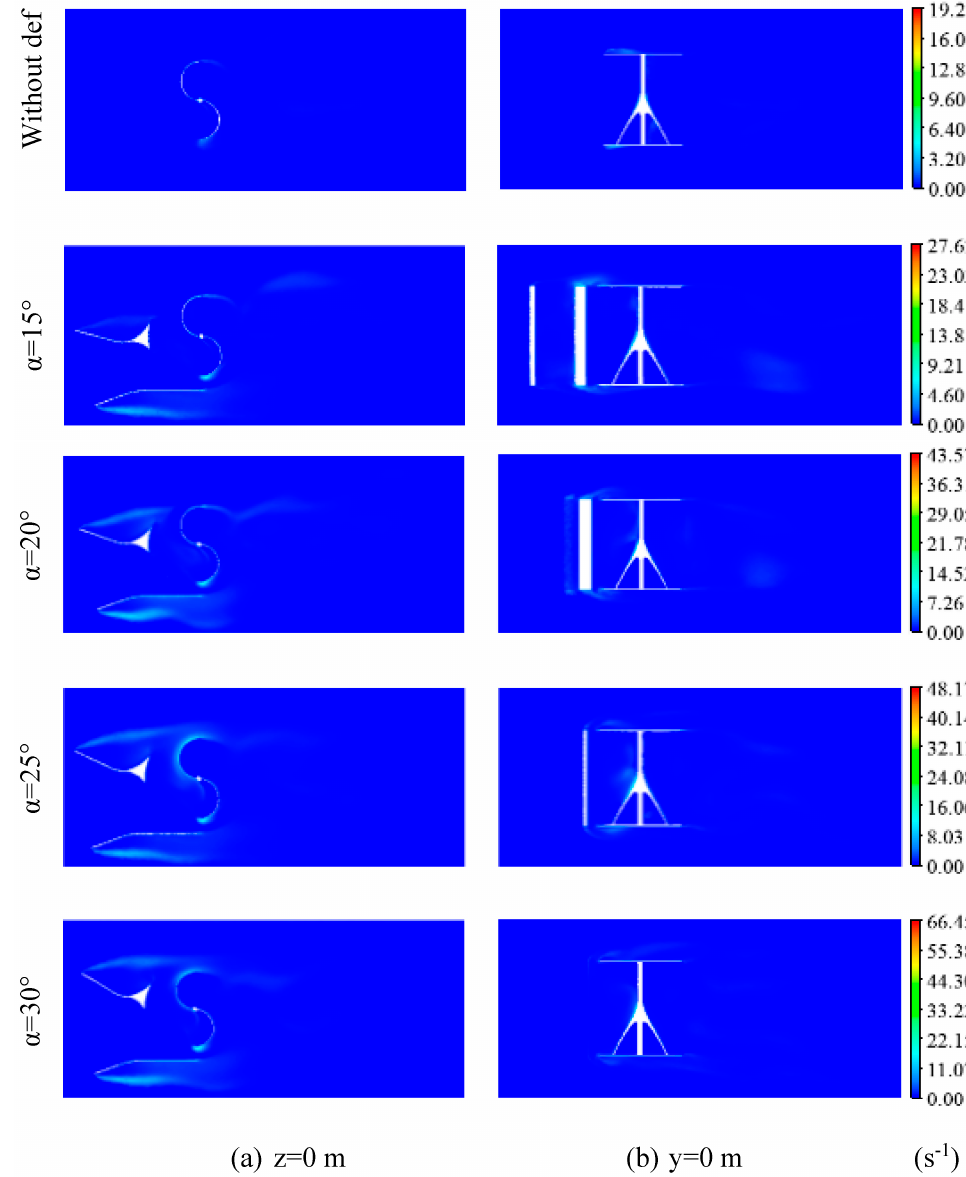
Figure 16. Turbulent eddy dissipation distribution for different deflection angles.